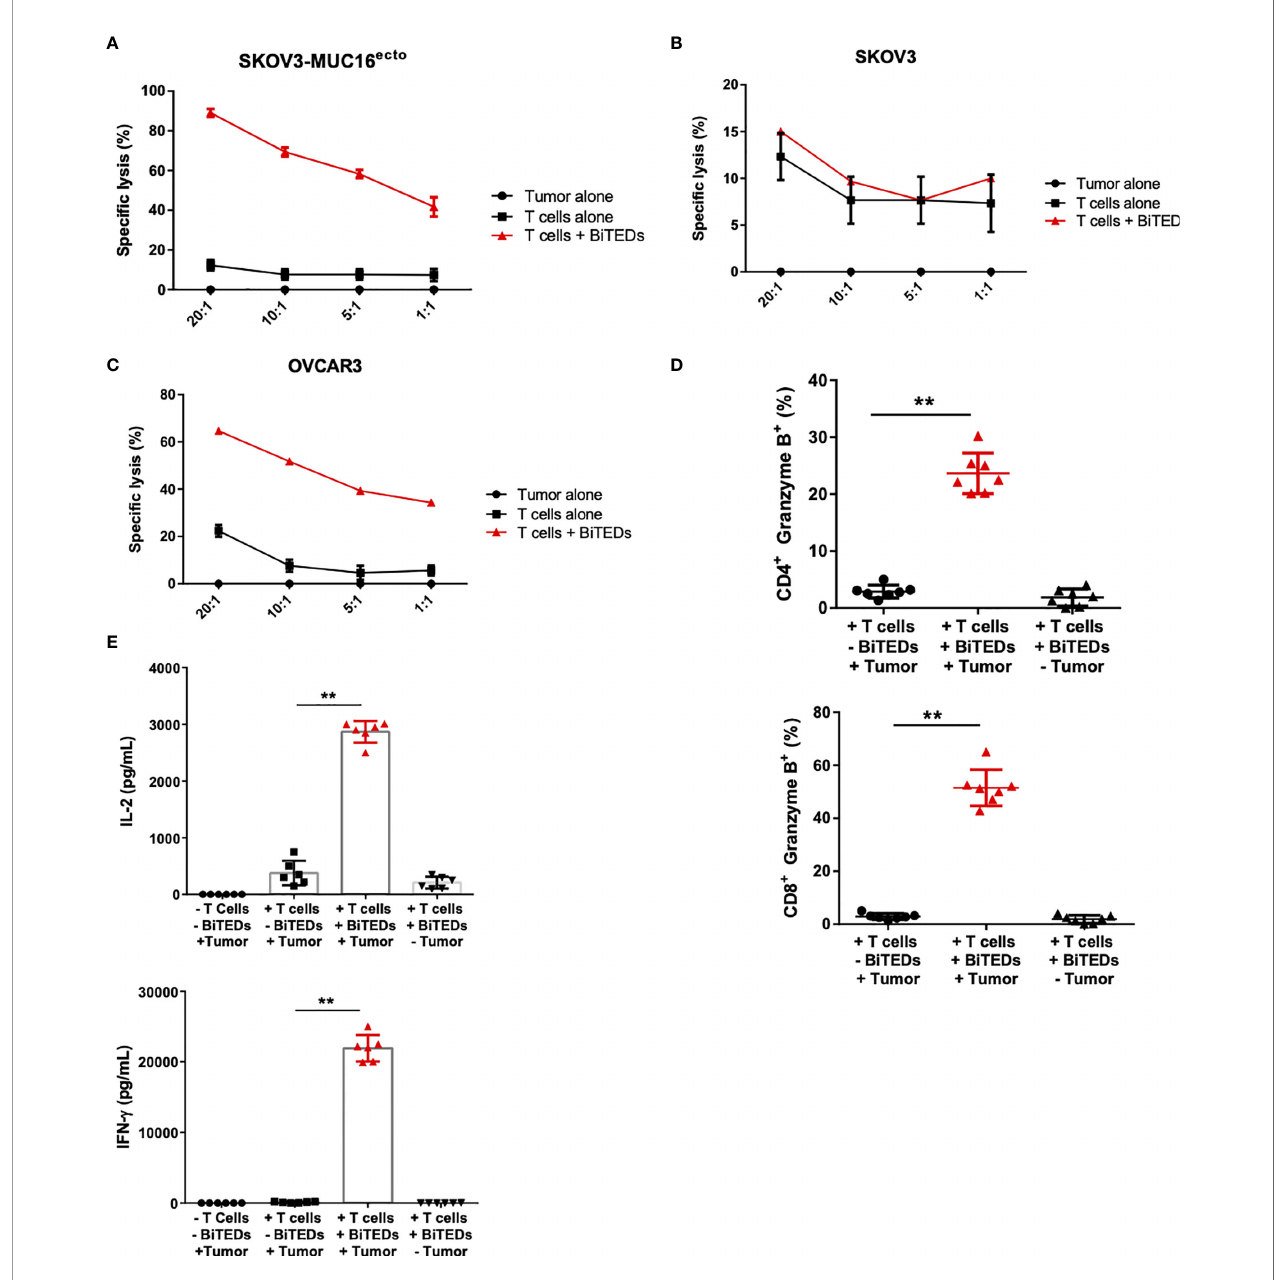
FIGURE 3 | MUC16 ecto -BITEDs display cytotoxicity against ovarian cancer cell lines in vitro. (A) Coculture of MUC16 ecto -BITEDs and activated T-cells and SKOV3- MUC16 ecto ; (B) with SKOV3, and (C) OVCAR3 tumor cells at the indicated E:T ratios. Data are plotted as mean ± SEM. Data shown are pooled results from 3 independent experiments. At least 4 separate donors were used for each experiment. Statistics performed using unpaired two-sided T test. (D) Percentages of Granzyme B positive CD4 and CD8 T-cells cocultured with SKOV3-MUC16 ecto cells with or without MUC16 ecto -BITEDs. (E) In vitro cytokine analysis of supernatants obtained from SKOV3-MUC16 ecto cells alone, and coculture of SKOV3-MUC16 ecto cells with T-cells with or without MUC16 ecto -BITEDs. For (D, E) , data shown are pooled results from 5 independent experiments with at least 4 independent donors. Data are plotted as mean ± SEM. **p <